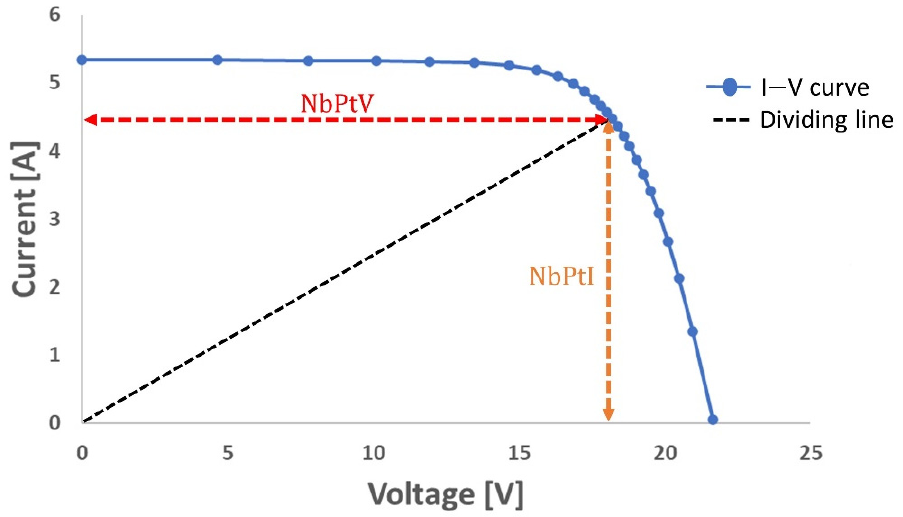
Figure 3. Logarithmic distribution of points on the I–V curve .